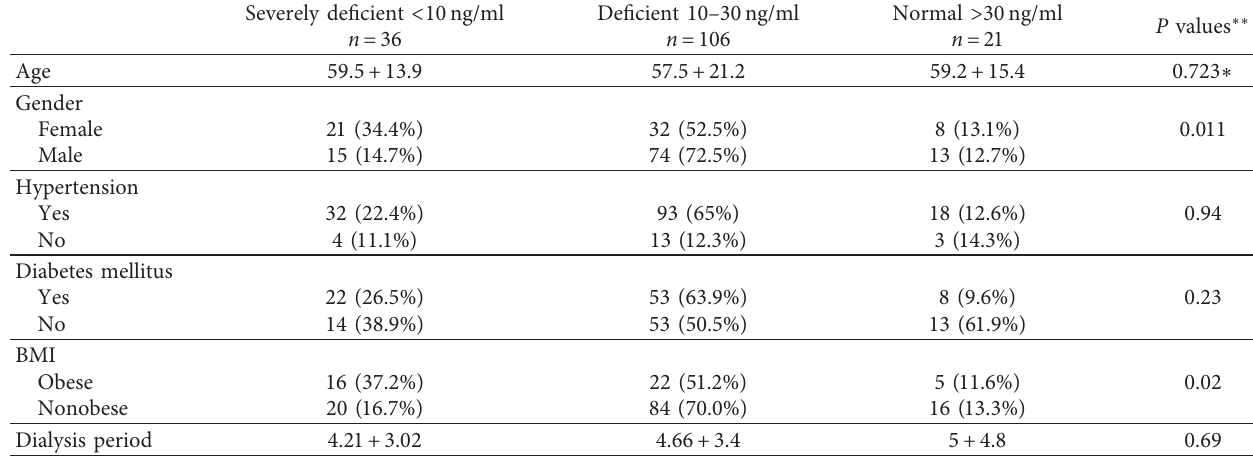
Table 2: Background and co-morbidities of dialysis patients according to serum 25 (OH)D levels.